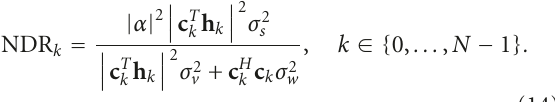
(a) The system structure with transparent receivers